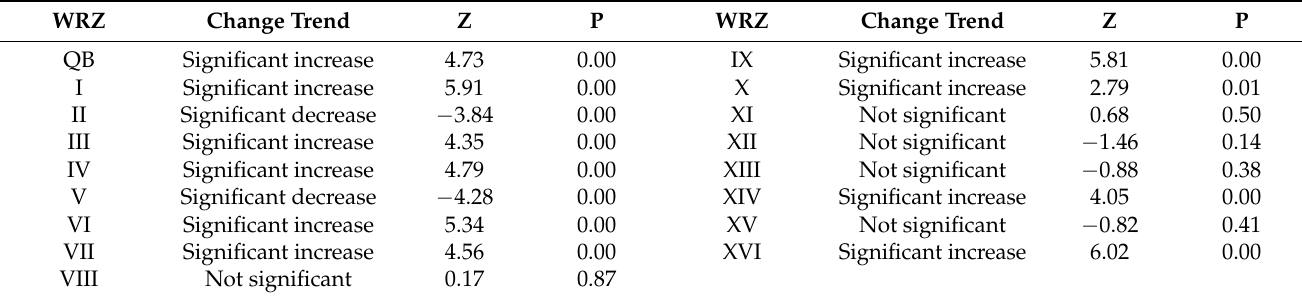
Table 7. Test results of the vegetation area trend in the Qaidam Basin from 1990 to 2020.